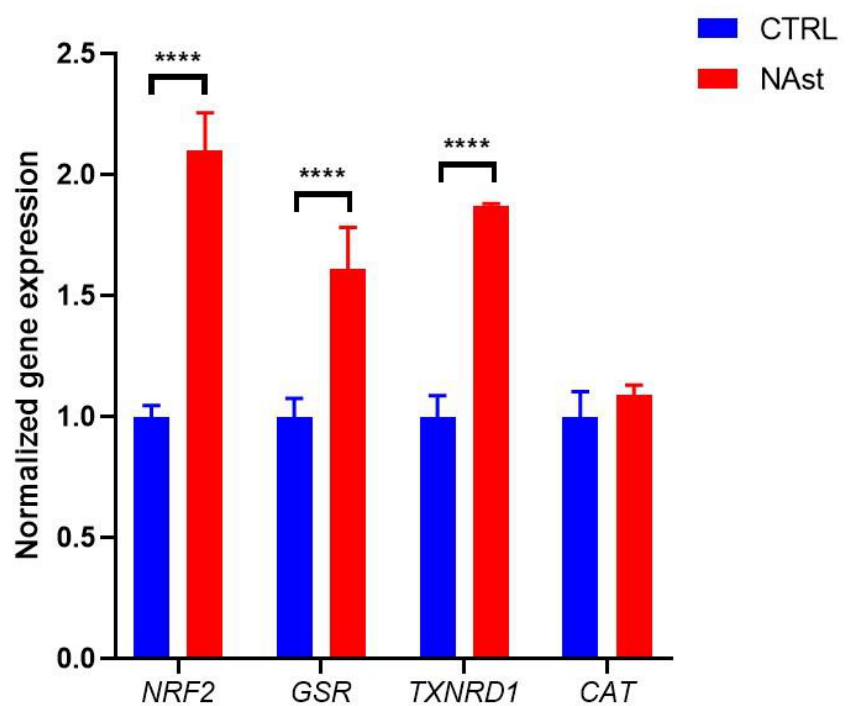
Figure 3. Normalized gene expression of NFE2L2 (Nrf2), GSR, TXNRD1, and CAT, analyzed by RT-PCR. Data are expressed as means of the relative expressions (fold changes) between the NAst treatments and the control samples. Data are shown as the means ± SDs of at least three independent experiments. **** p ≤ 0.001 vs. control.